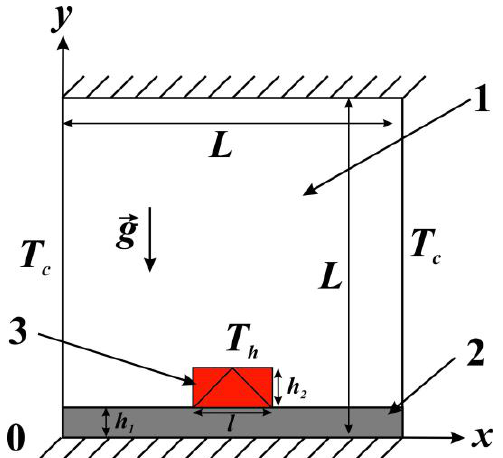
Figure 1. Computational domain: 1–air filled cavity, 2–heat-conducting substrate, 3–heat source.